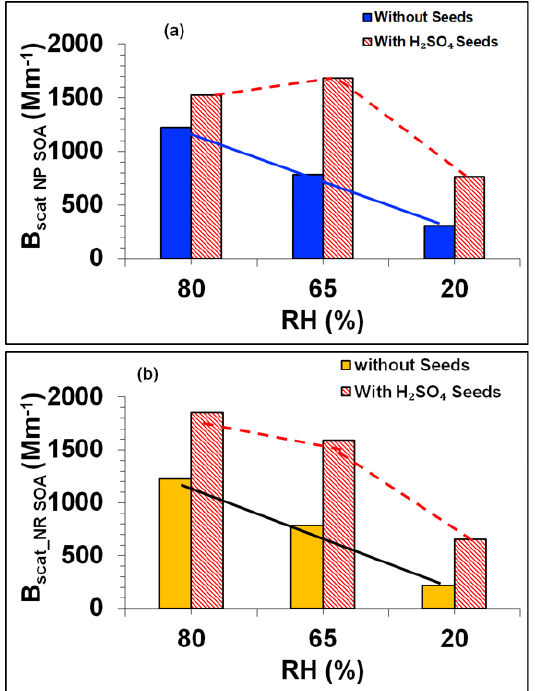
Figure 15. ( a , b ): Effects of water vapour and acidity on the B scat of toluene SOA. ( a ) B scat of NP SOA for the H 2 SO 4 seeded and non-seeded experiments at the three RHs; ( b ) B scat of NR SOA for the H 2 SO 4 seeded and non-seeded experiments at the three RHs. The solid and dashed lines are eye guides.